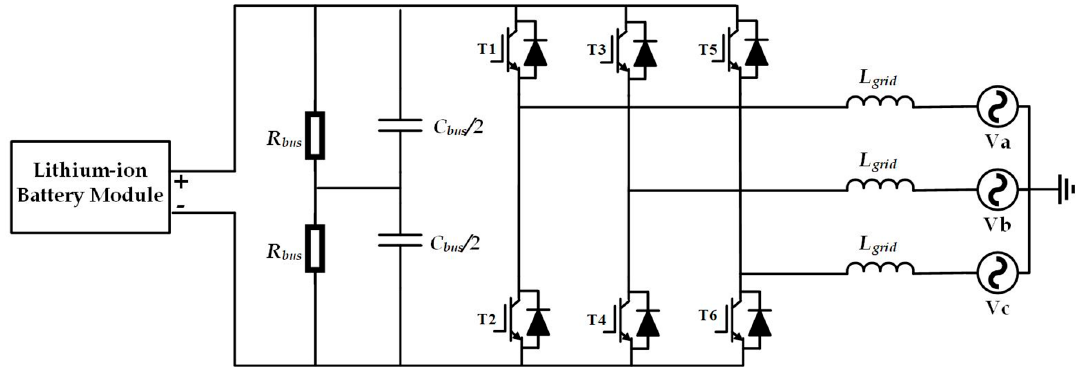
Figure 16. Simulink model of the FB for Heavy-Duty Vehicles. Table 8. Main characteristics of the Heavy-Duty system connected to HV Batteries.